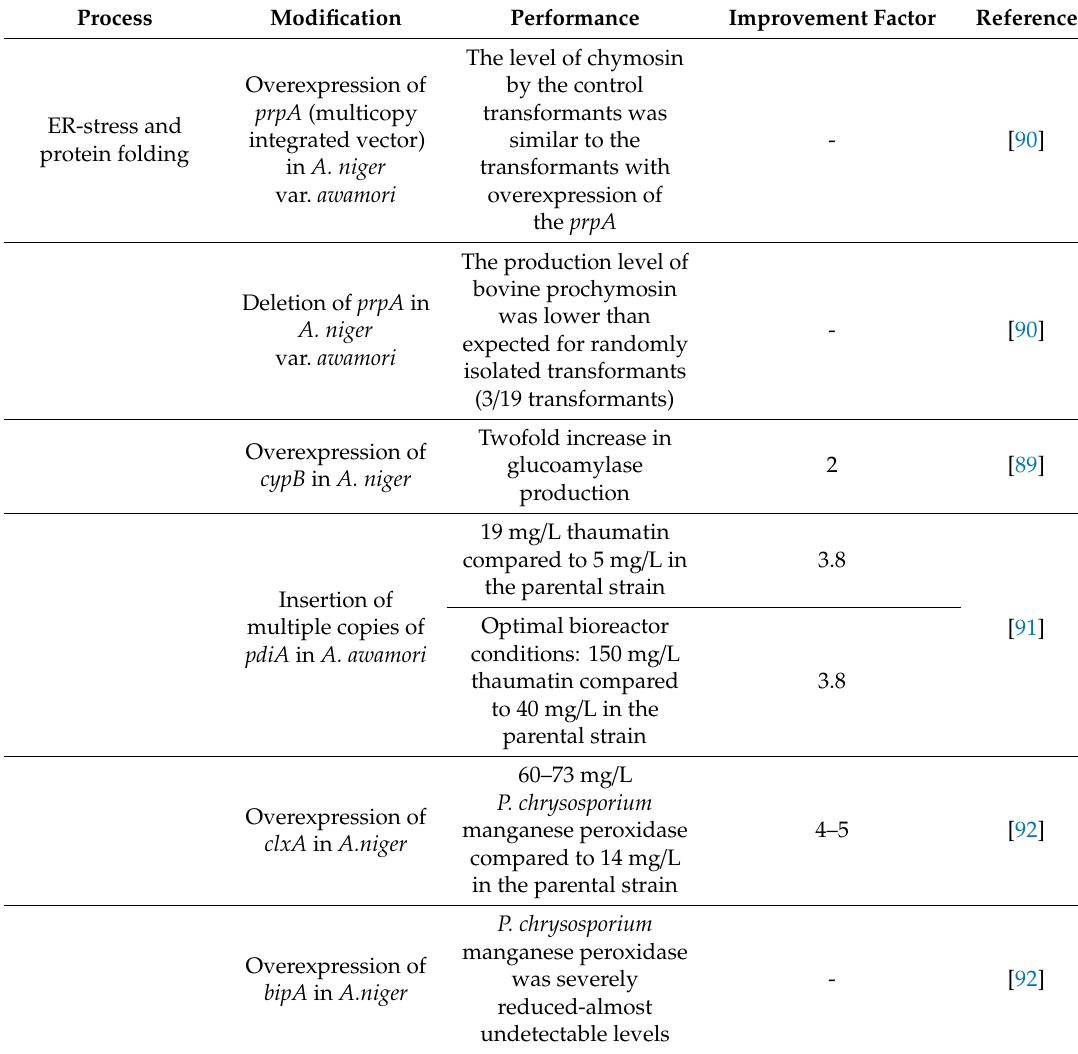
Approaches for improving recombinant protein production through engineering unfolded-protein response (UPR)